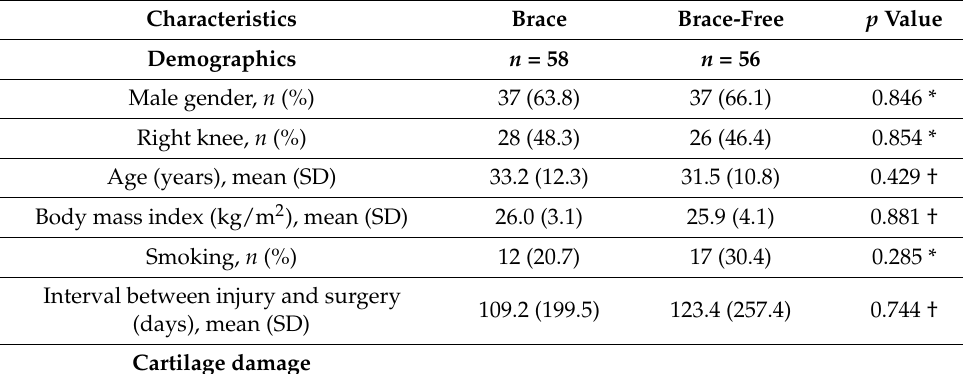
Table 1. Baseline characteristics of patients allocated to the brace-free and brace-based study groups. Values represent means (standard deviations) unless stated otherwise. One patient (with brace) underwent both medial and lateral meniscus